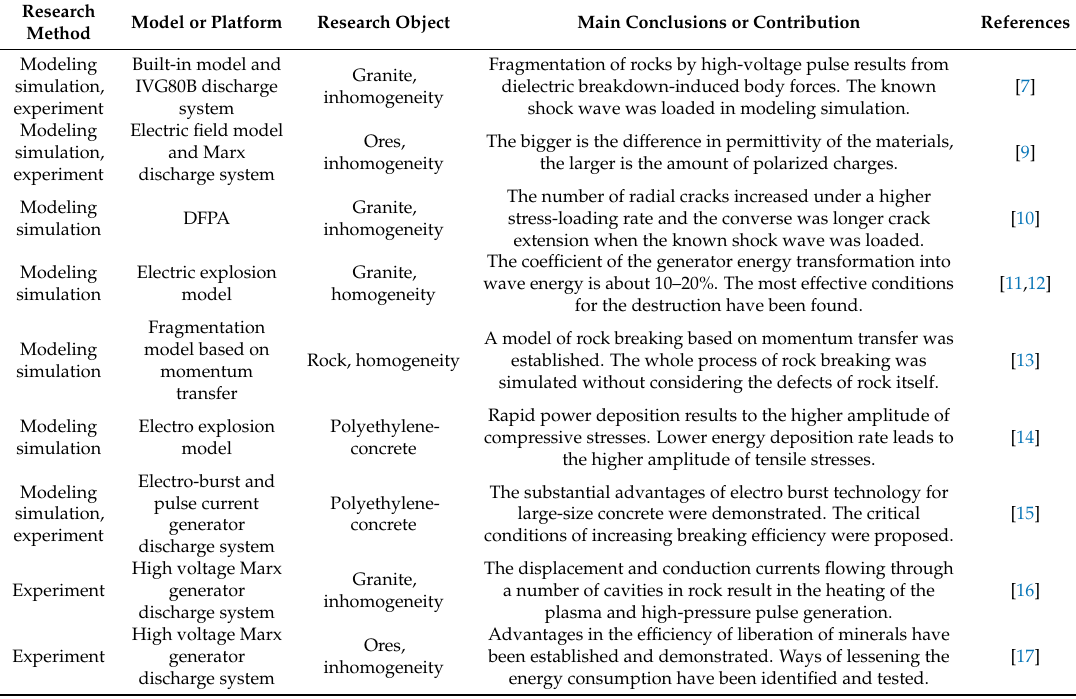
Table 1. Review of previous studies on mechanical model and breakage mechanism by